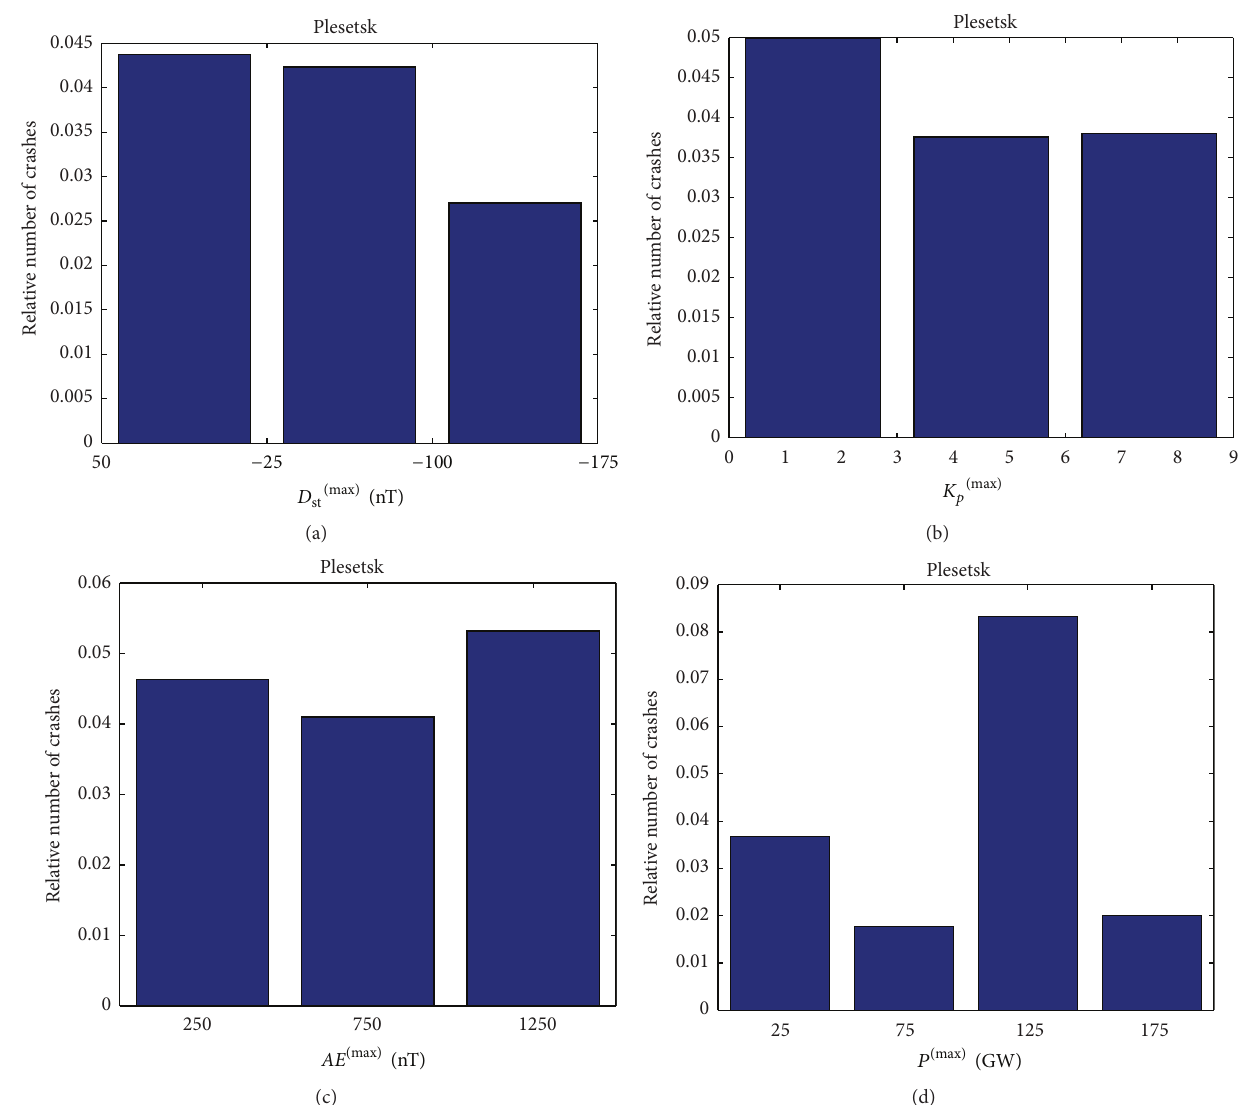
Figure 14: Relative number of crashes for different levels of geomagnetic indices at Plesetsk: (a) 𝐷 𝑃